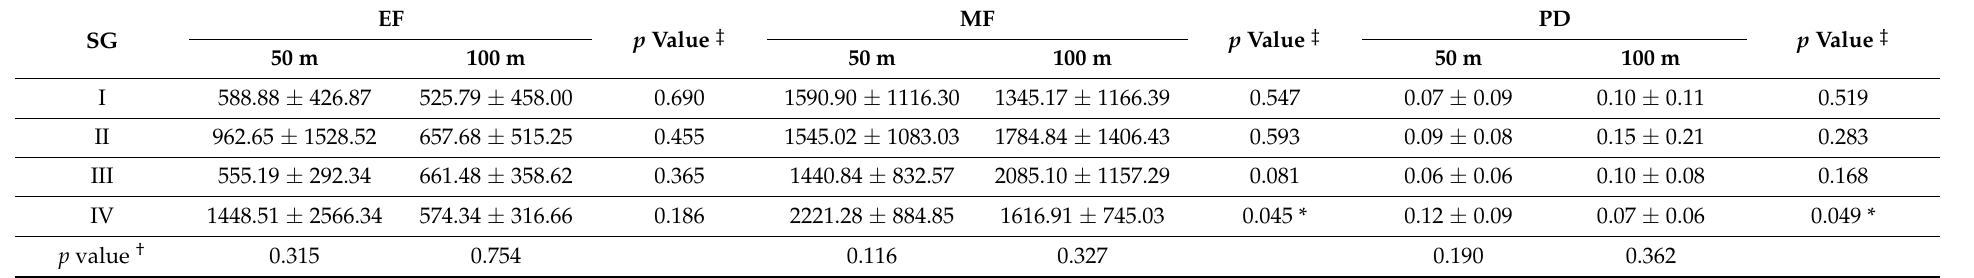
Table 2. Inter- and intragroup comparative analysis of electric field strength, magnetic field strength and power density among the study group at different distances.